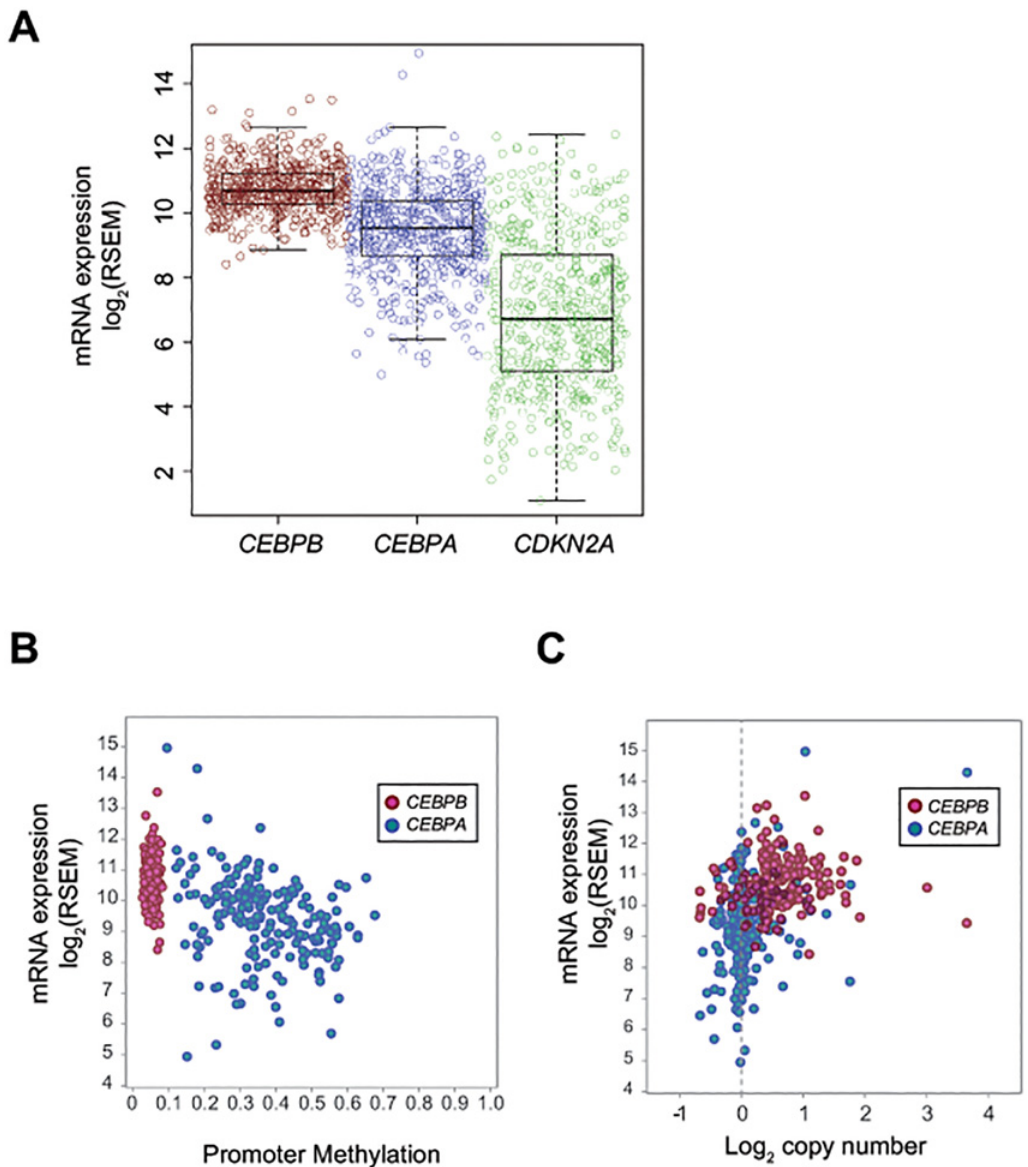
Fig 6. C/EBP β is not altered in human lung adenocarcinoma. (A) mRNA expression of CEBPA , CEBPB , and CDKN2A in TCGA lung adenocarcinoma dataset. RSEM values obtained from TCGA data were log 2 transformed and depicted as individual dots representing a sample and box plot. (B) Methylation status in CEBPA and CEBPB promoter regions in TCGA lung adenocarcinoma dataset. Scatter plot depicts mRNA expression in Y-axis and methylation level of the promoter region in X-axis of CEBPA and CEBPB genes. (C) Copy number estimates of CEBPA and CEBPB gene loci in TCGA lung adenocarcinoma dataset. Scatter plot depicts mRNA expression in Y-axis and copy number estimates in log 2 scale in X-axis of CEBPA and CEBPB